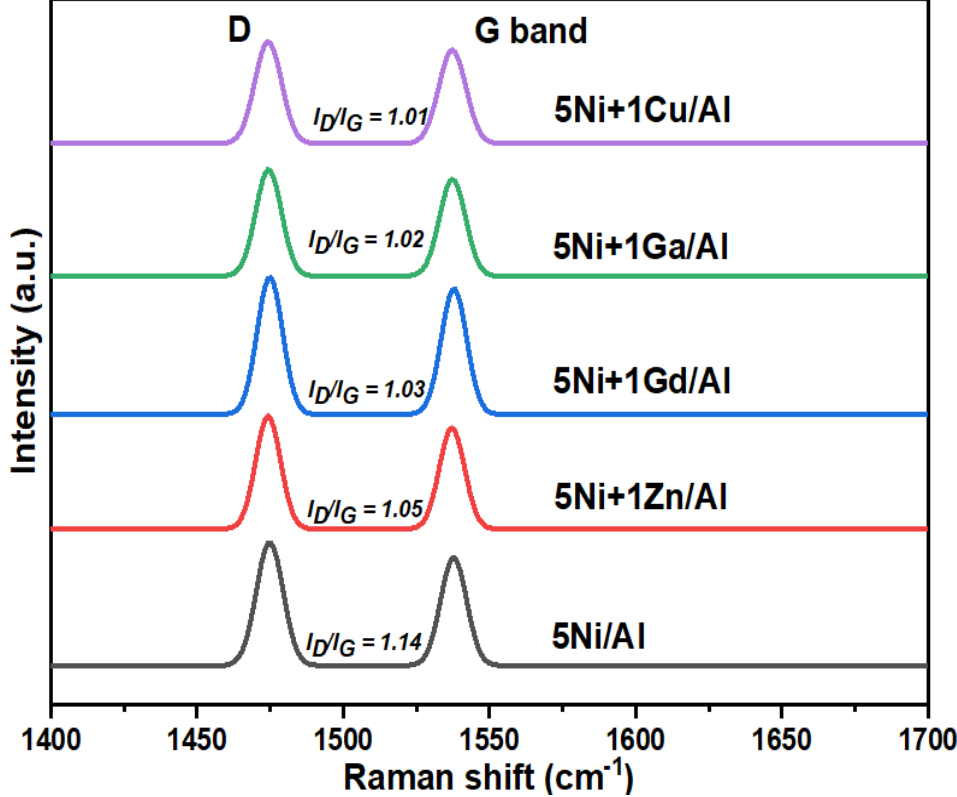
Figure 7. Raman spectra for the spent catalysts.